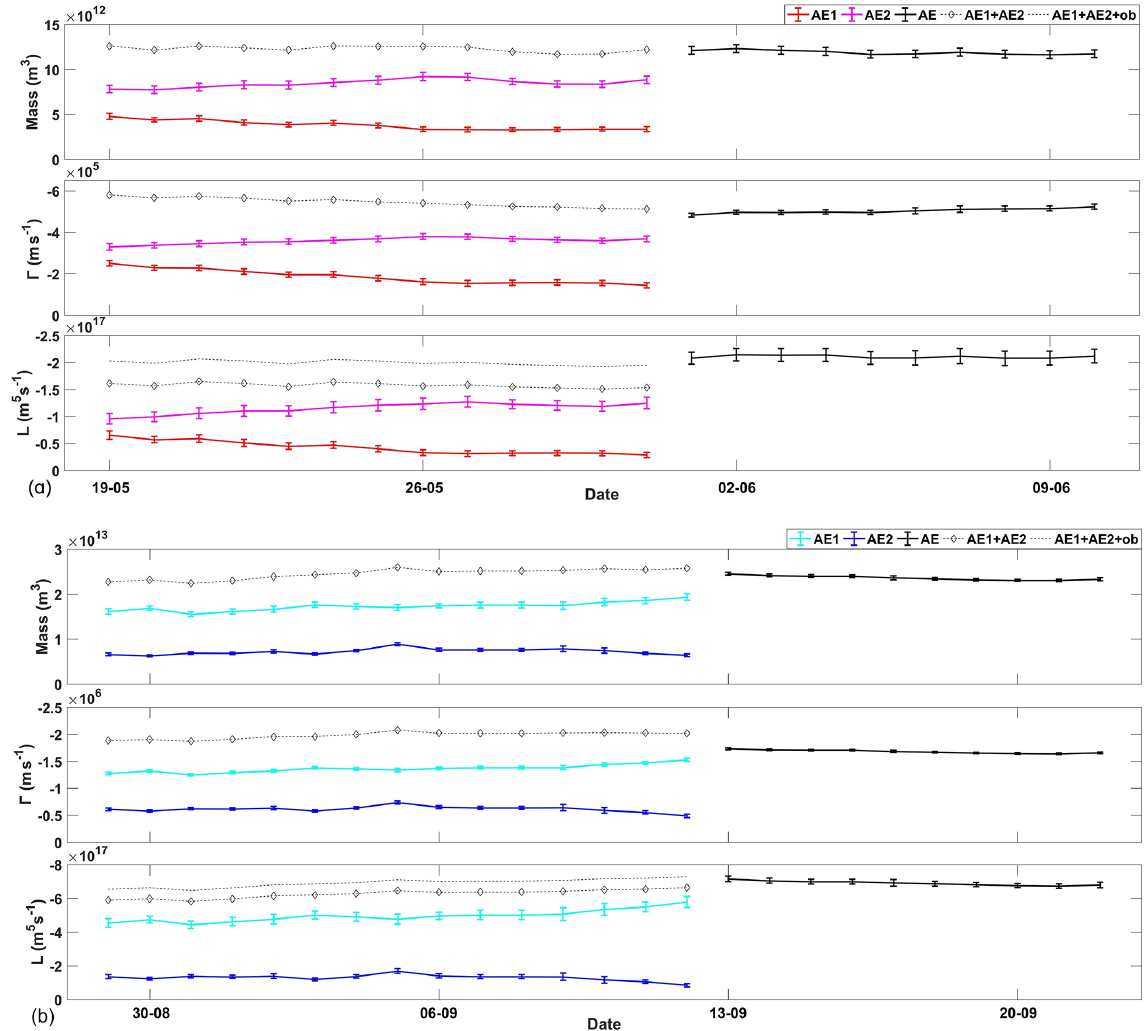
Figure 7. There are two panels. The eddy properties (mass, circulation, and angular momentum) with a larger lateral boundary of integration in the merging event of (a) surface mesoscale eddies and (b) subsurface mesoscale